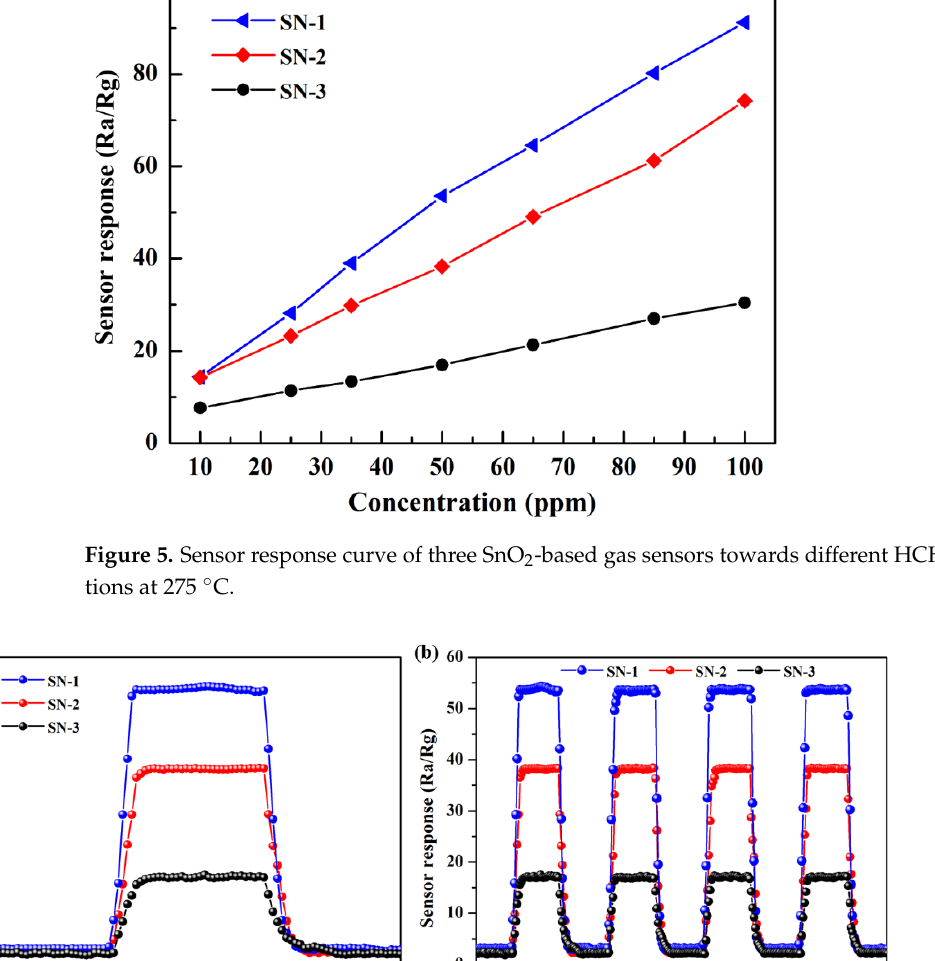
Figure 7. The long-term stability of three SnO 2 -based gas sensors towards 50 ppm HCHO at 275 °C. 3.3. Gas-Sensing Mechanism As is known to all, the SnO 2 -based gas sensor is the surface-controlled sensor [25]. The gas-sensing mechanism could be elucidated by conductivity change, which is caused by surface interactions between the target gas and the SnO 2 -sensing surface (as shown in Figure 8). Firstly, when exposed to air, the oxygen in the air is adsorbed on the surface of the SnO 2 -sensing film to generate different types of oxygen ions (O 2 − , O − and O 2 − ) by trap- ping free electrons from the SnO 2 conduction band. This results in a reduction in carrier concentration and can form an electron depletion layer on the surface of SnO 2 nanomateri- als. Consequently, the resistance of SnO 2 -based sensors in air atmospheres increases. Then, a surface interaction between HCHO gas and the oxygen ions occurs when the